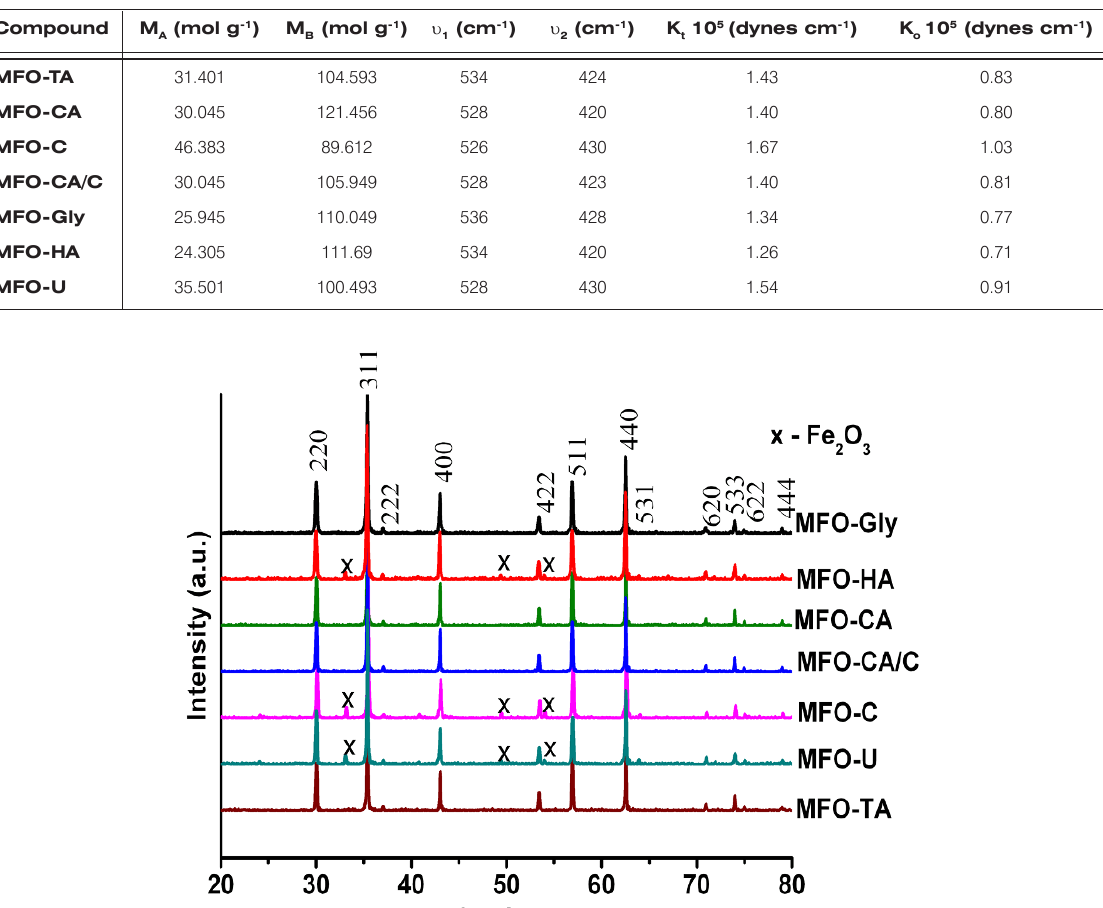
, M ), wavenumbers ( υ 1 2